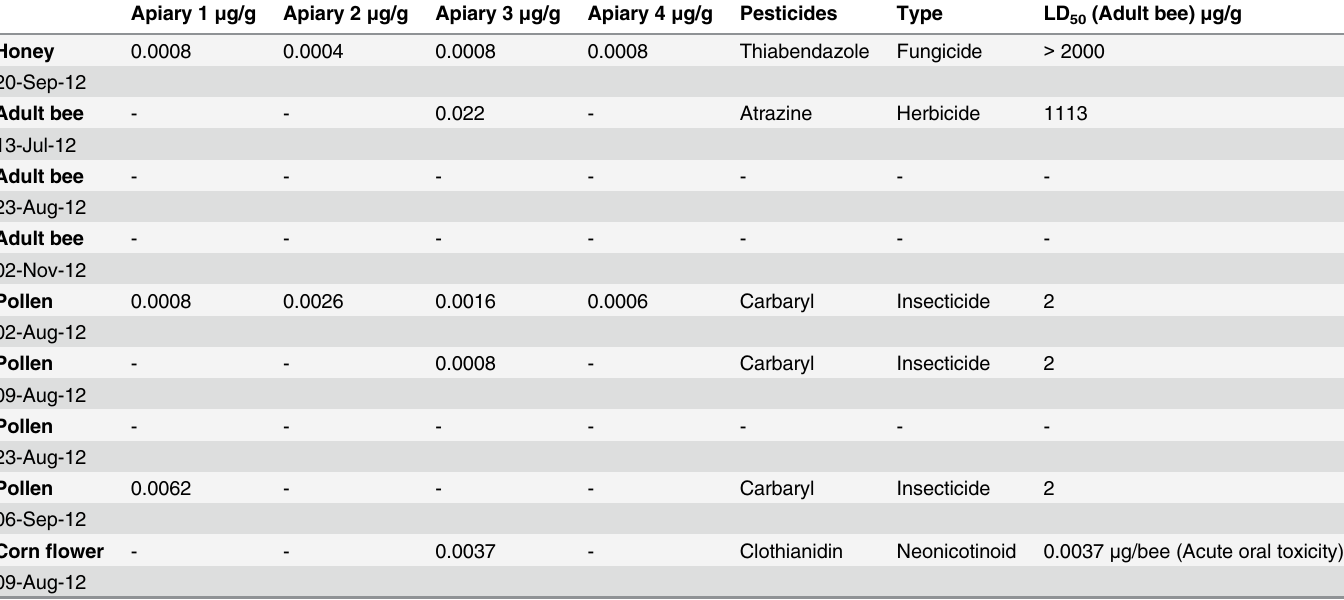
Table 3. Chemical pesticide residue analyzed by (LC-MS) for honey, adult bee, pollen and corn flower from the four studied locations on different dates. Apiary 1 μ